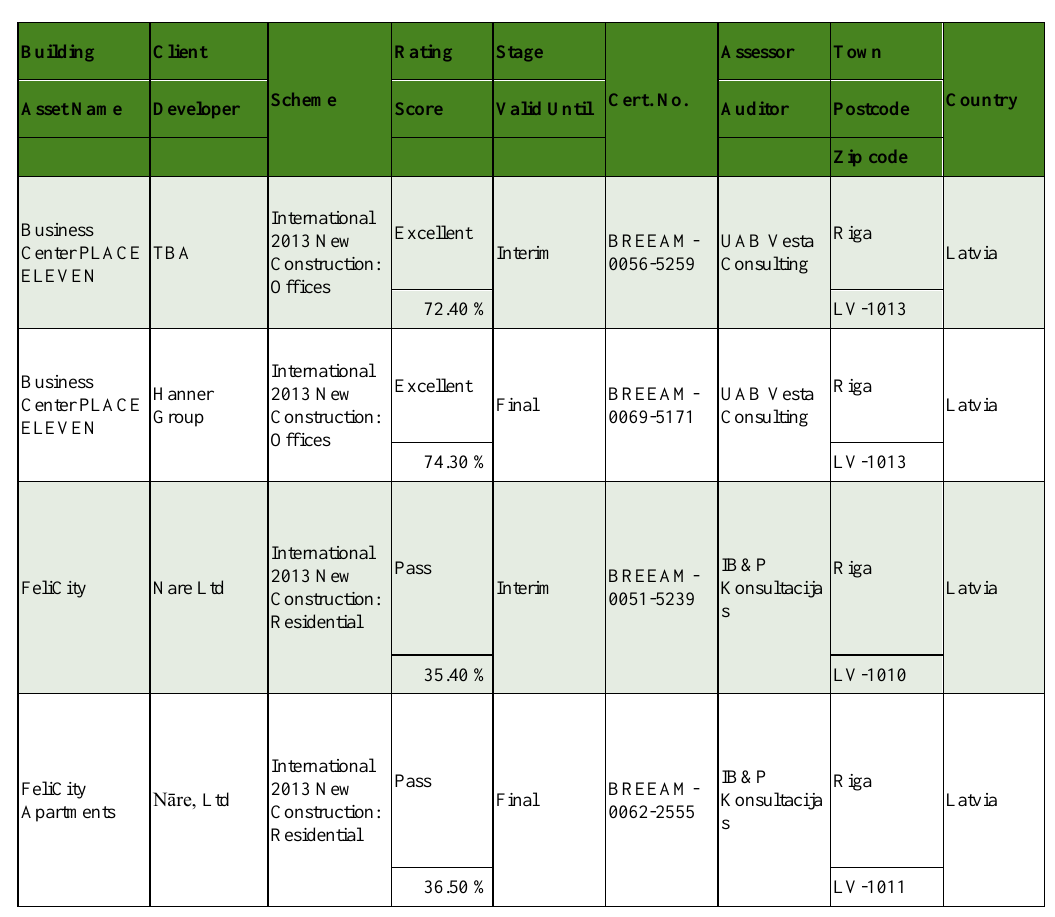
Table 6. BREEAM certified projects in Latvia on August 31, 2017 (BRE Group, n.